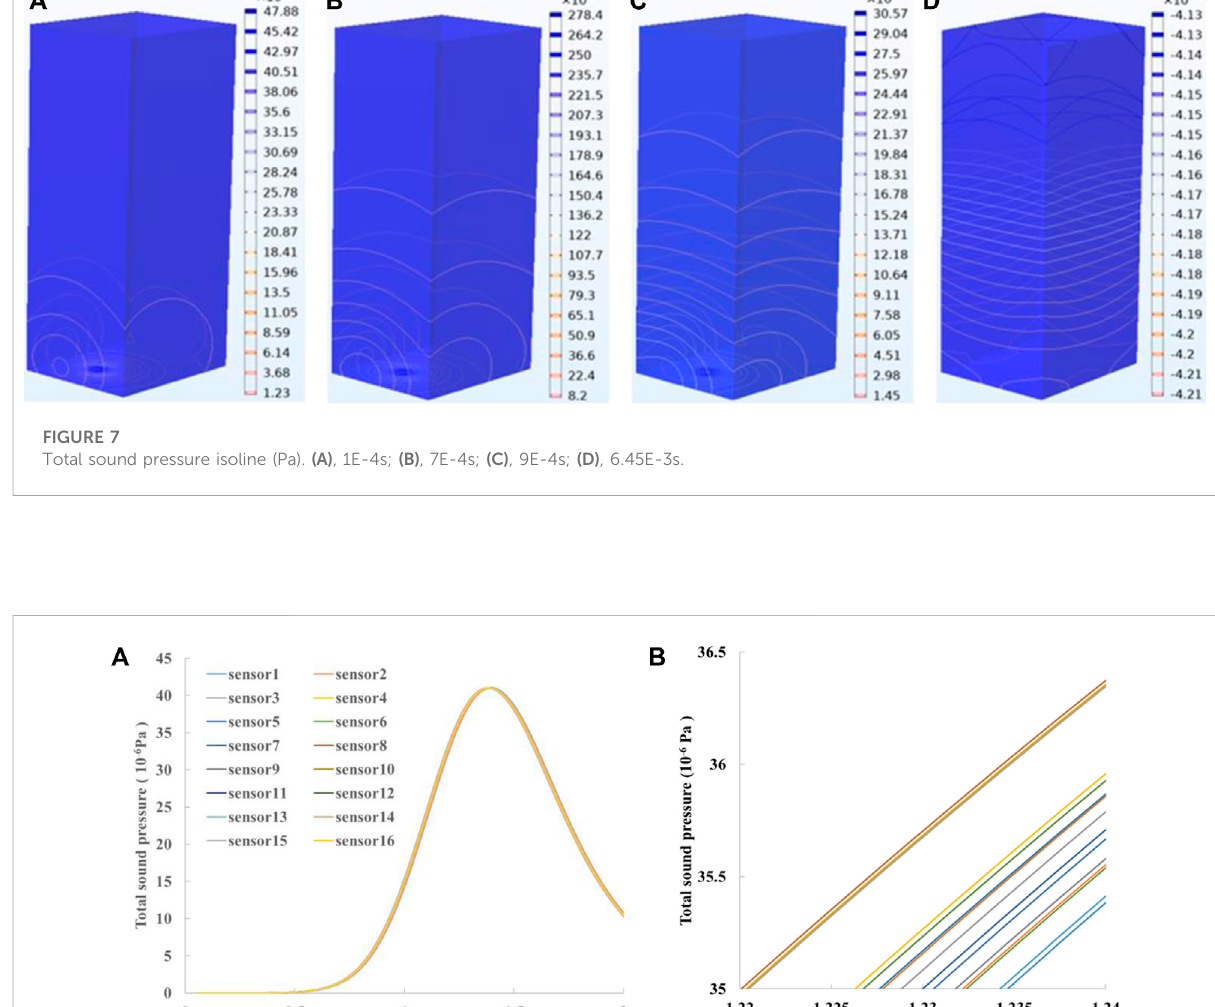
The cracks induced by hydraulic fracturing in the two stages are mainly extended in the northeast and southwest directions,